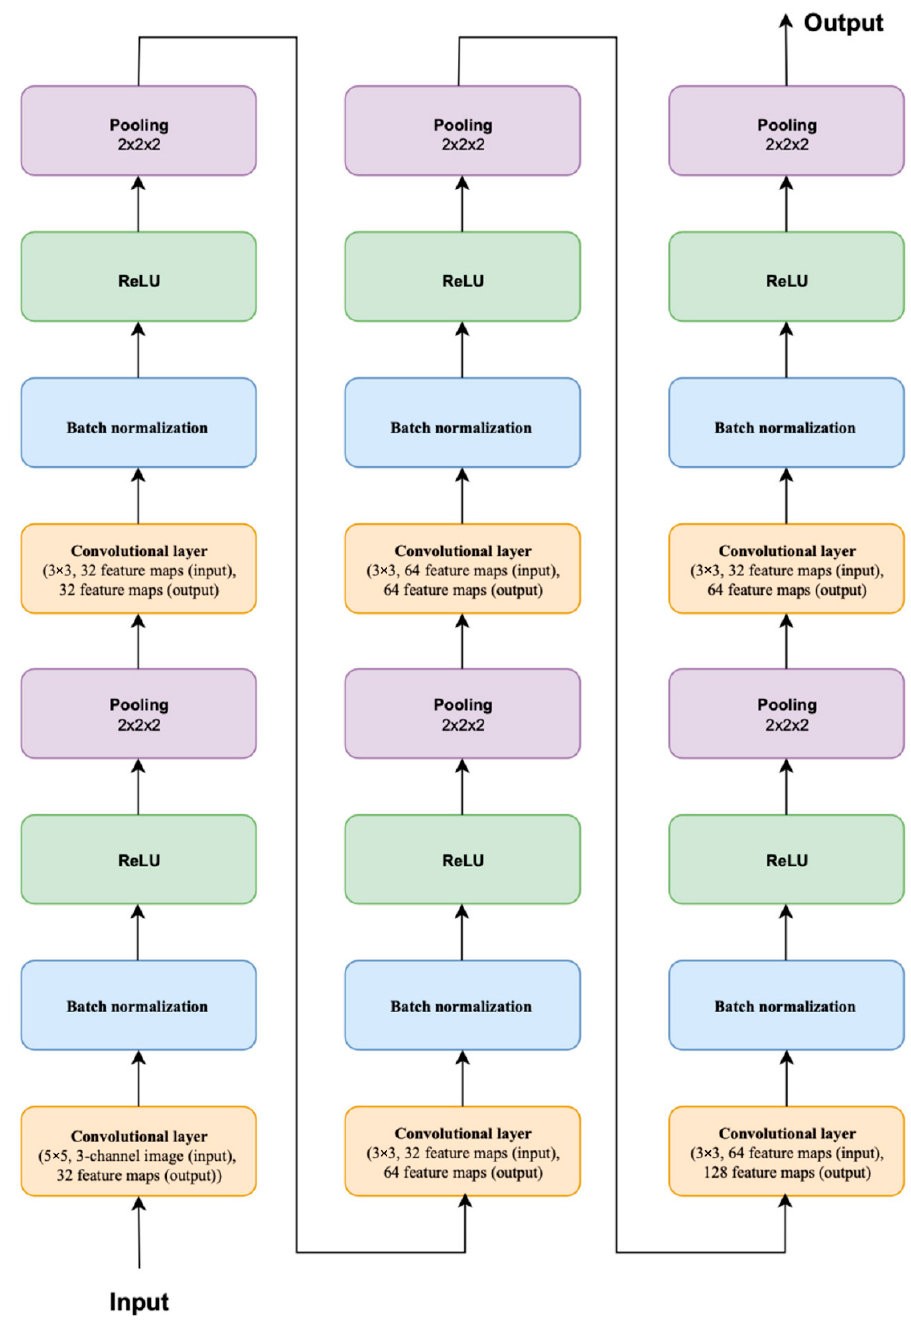
Figure 6. Neural network architecture.